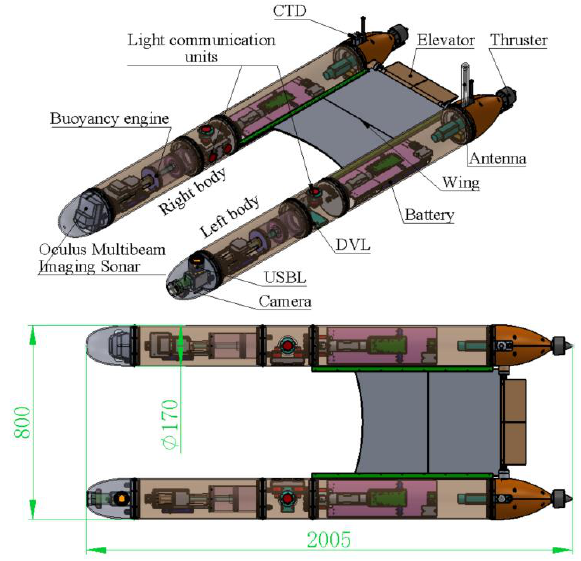
Figure 1. The structure of the THAUV.